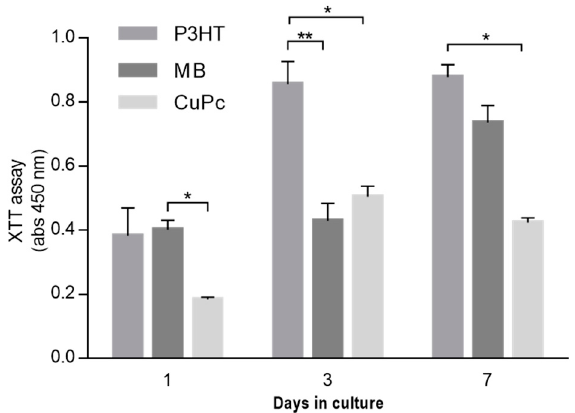
Figure 7. Cell proliferation of L929 cells seeded onto PVDF composites of P3HT, MB, and CuPc electrospun fibers. (* p < 0.05; ** p < 0.01). All the results were normalized with respect to PVDF fibers used as positive control.